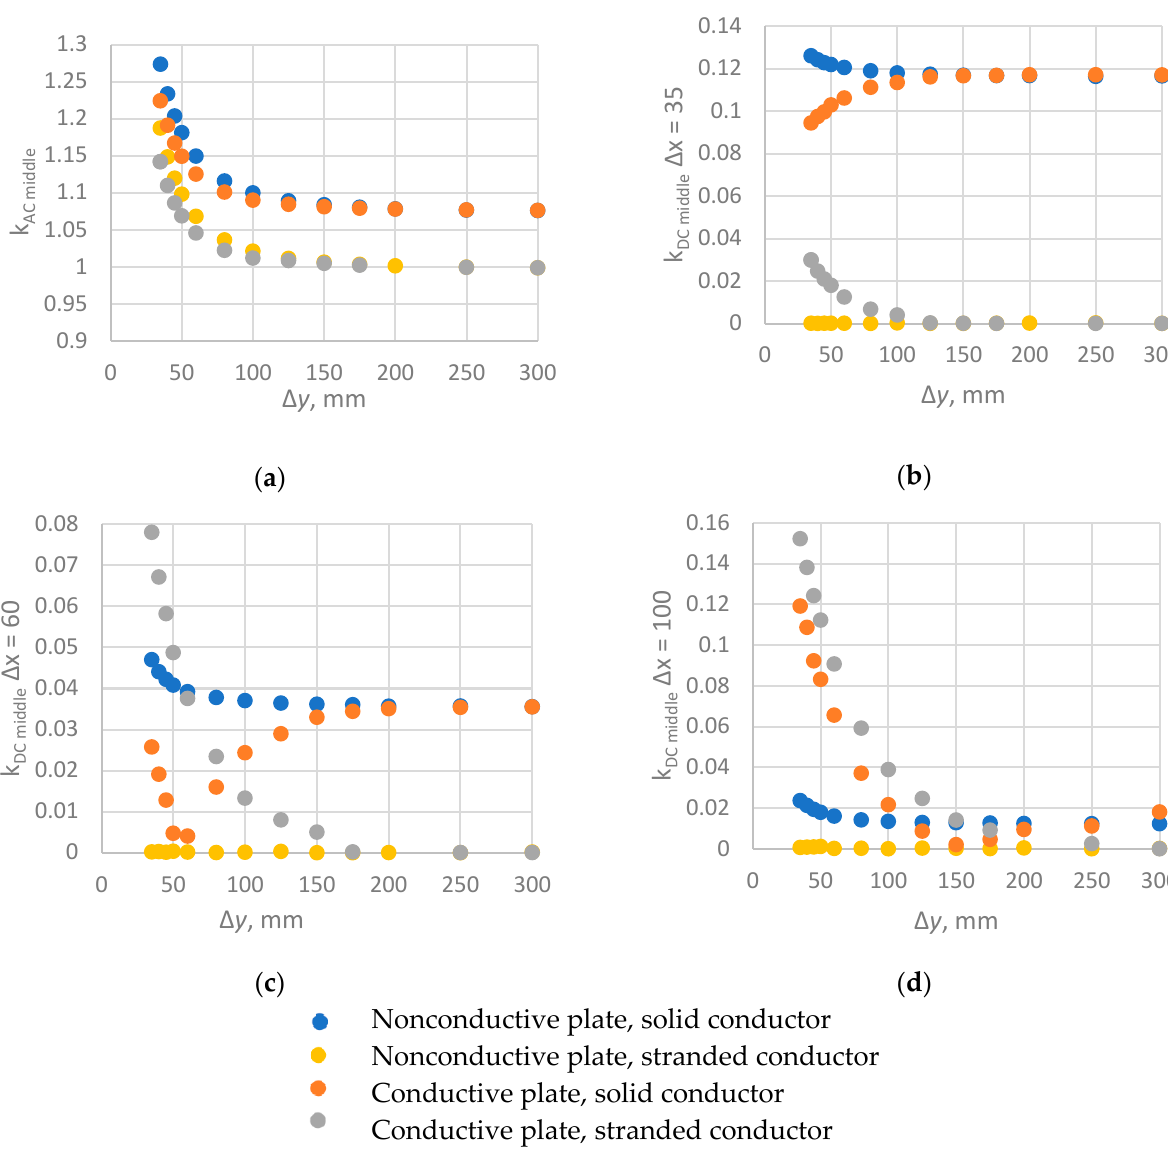
Figure 6. Correction factors: ( a ) k AC middle for Δ x = 35; ( b ) k DC middle for Δ x = 35: ( c ) k DC middle for Δ x = 60; ( d ) k DC middle for Δ x = 100; as a function of core plate distance.